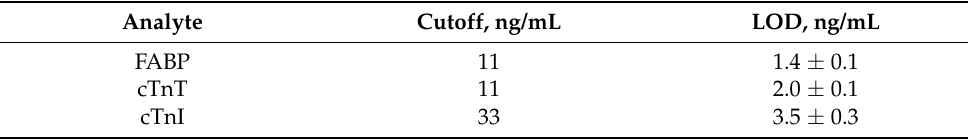
Table 1. Analytical characteristics of GNS-based test systems.